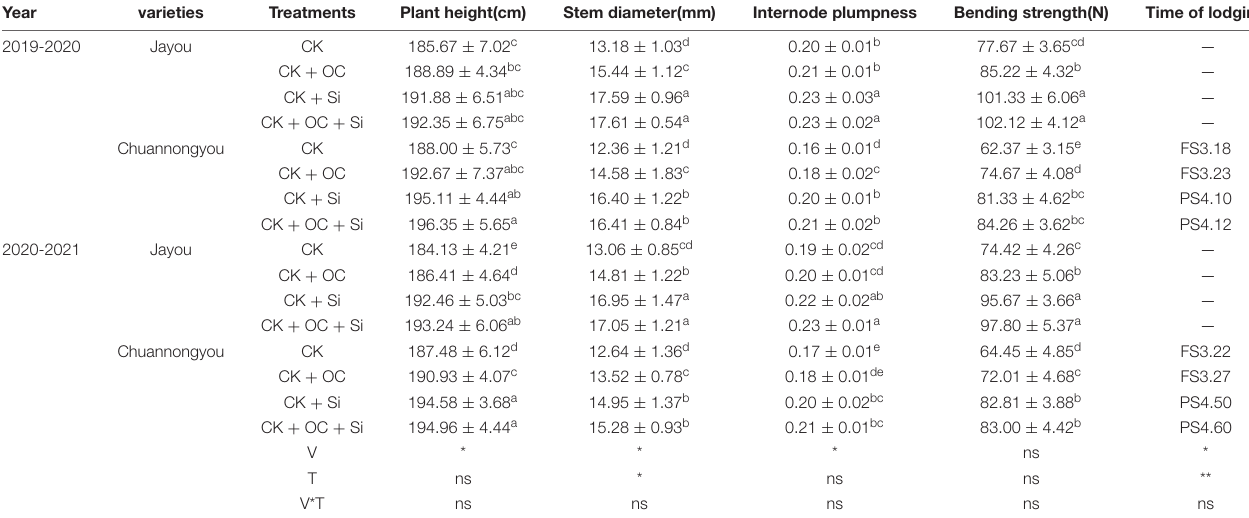
TABLE 2 | Effects of different fertilizer treatments on stem traits of rapeseed.